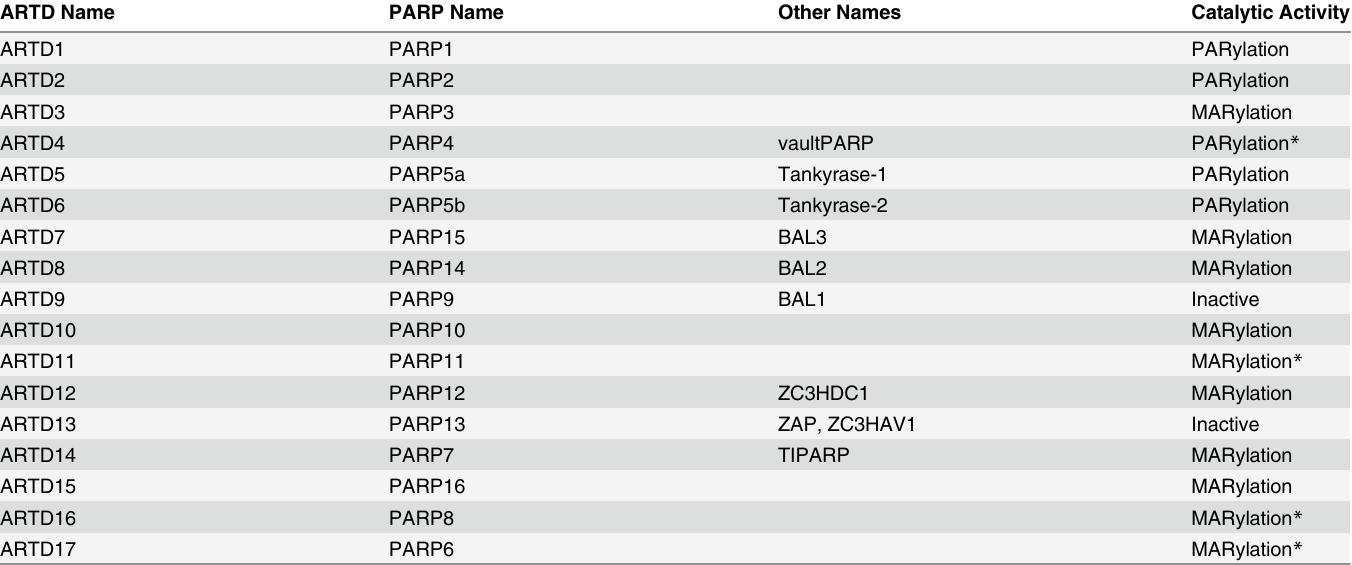
Table 1. ARTD/PARP